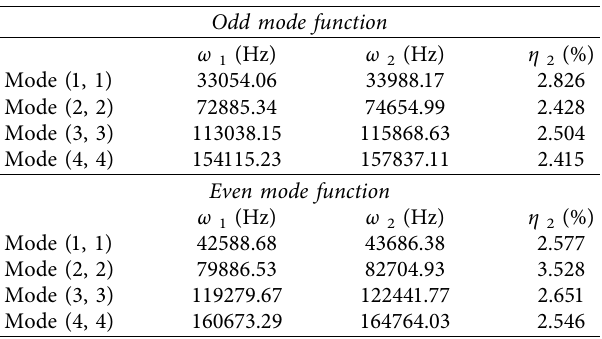
Table 4: Comparison of the multiscale method and the numerical